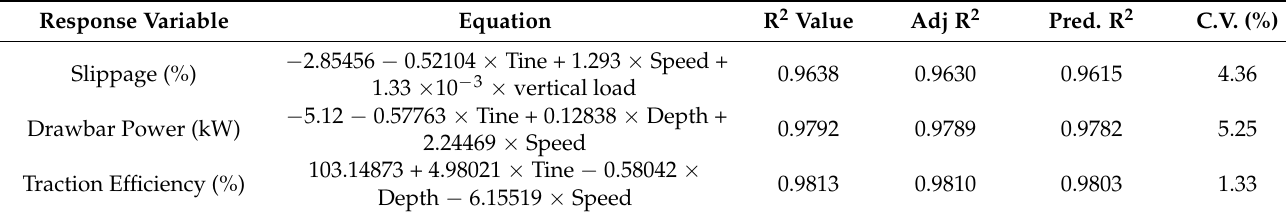
Table 4. Regression equations of response